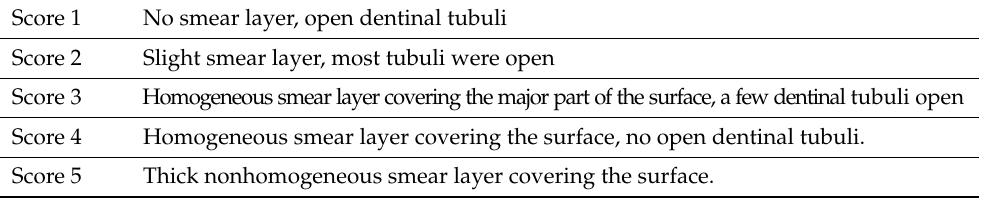
Table 2. Hülsmann criteria for smear layer scoring.